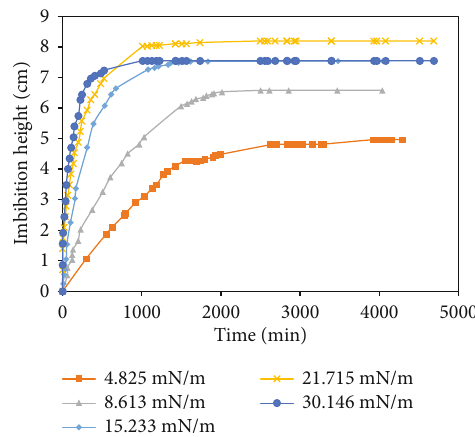
Figure 2: Change in imbibition height with time under di ff erent interfacial tensions with a salinity of 0 mg/L.